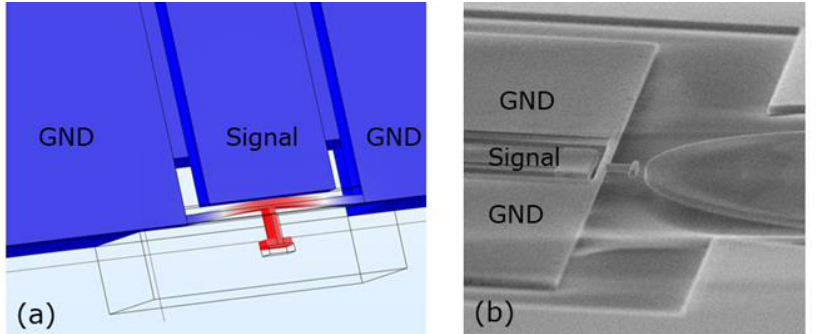
Figure 13. ( a ) Finite element simulation (FEM) of an electrostatically actuated doubly clamped hammerhead cantilever beam. The beam deflects 50 nm for an applied voltage of 50 V for a 250 nm starting gap. ( b ) Scanning electron microscope (SEM) image of a fully released MEMS device after metal overlay and oxide removal at Bristol.